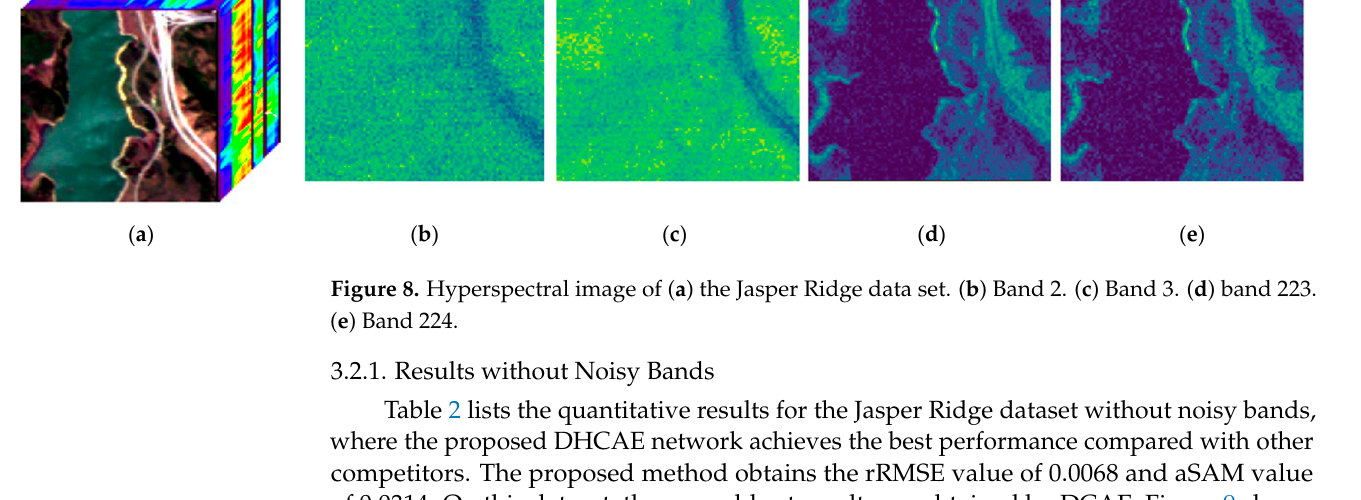
Table 2. Quantitative performance on the Jasper Ridge dataset without noisy bands by various ap- proaches. The best result is shown in bold.